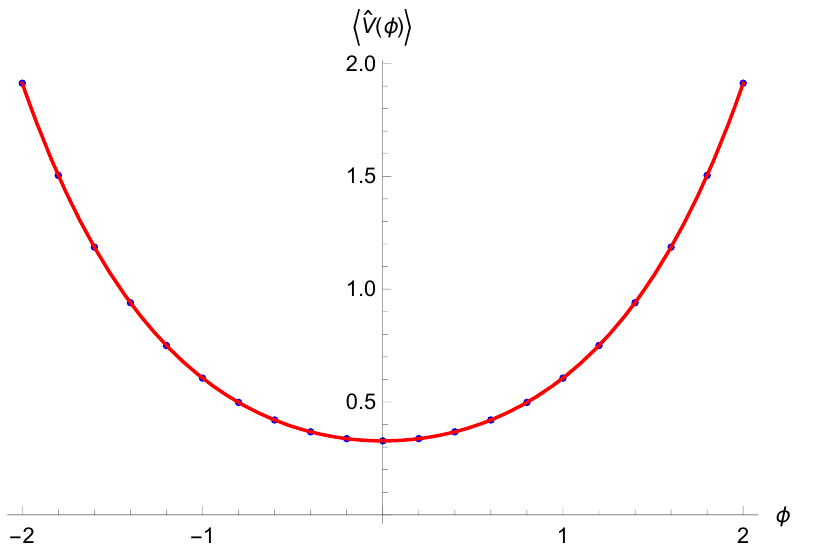
Figure 11. The expectation value of the Universe volume as a function of time (blue dots), fitted with a function in accordance with the semiclassical evolution (continuous red